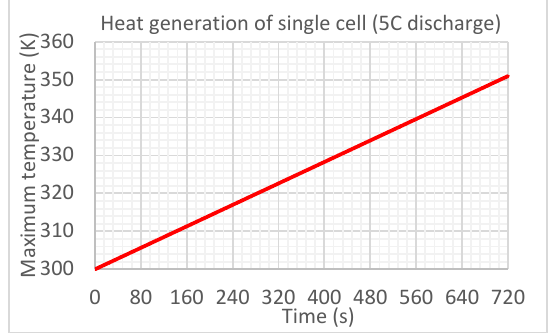
Figure 2. Heat generation of a single cell